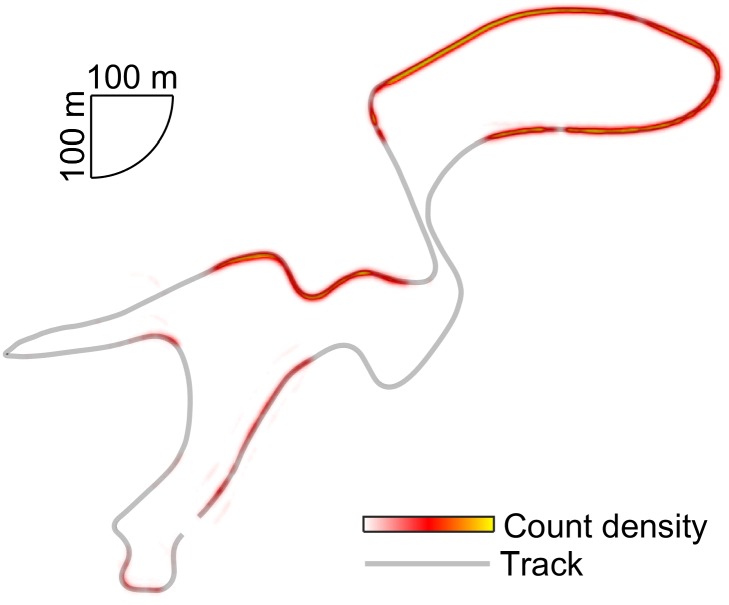
Heat map showing the spatial distribution of received ZXY-Go coordinates. The mapping trajectory is plotted in gray.